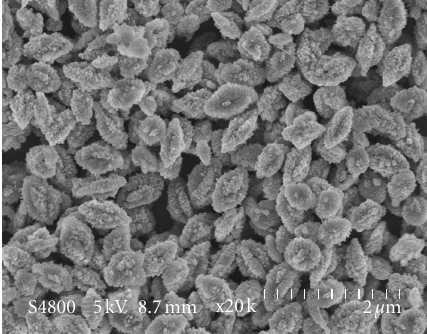
Figure 1: SEM image of shuttlelike CuO nanocrystal